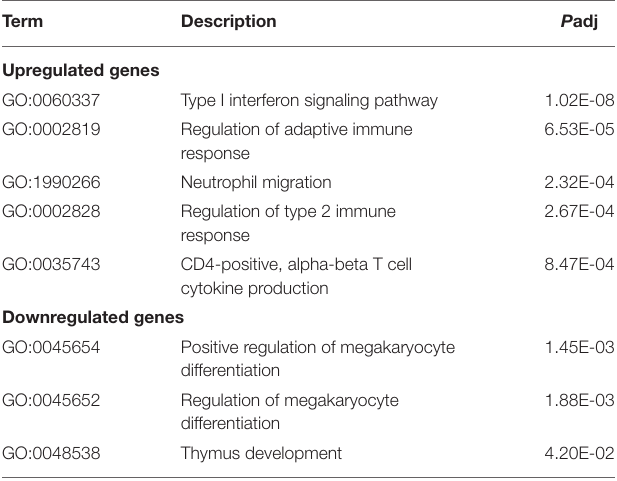
TABLE 2 | Gene ontology (GO) (immune system process) analysis of differentially expressed genes (DEGs). Term